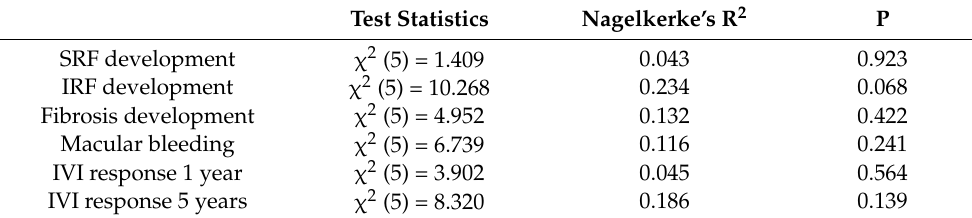
Table 5. Receiver operator characteristic. Values are given as area under the curve analysis. ab, antibody; AT1, Angiotensin II receptor 1; IRF, intraretinal fluid; IVI, intravitreal injection; PAR1, Protease-activated receptors; SRF, subretinal fluid; VEGF, vascular endothelial growth factor.